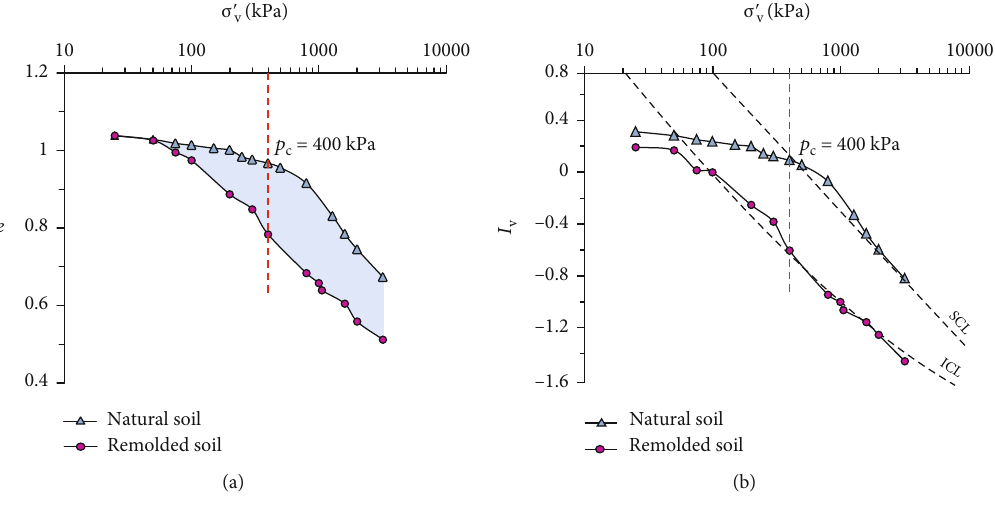
Figure 6: Compression behavior of natural and remolded GRS: (a) e – log σ